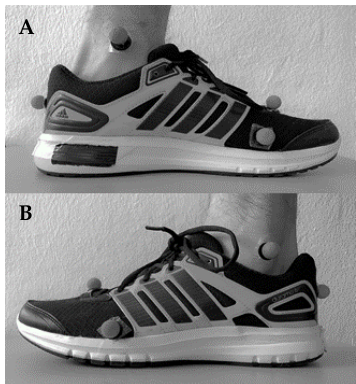
Figure 1. A medial view ( A ) and lateral view ( B ) of the left foot marker placements can be seen on the test shoe.